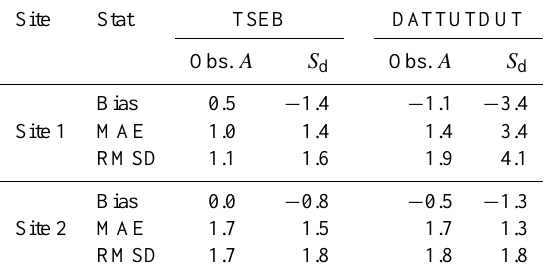
Table 4. Difference statistics for daytime ET (MJm − 2 day − 1 ) ex- trapolated from instantaneous estimates using observed available energy A (obs. A ) from flux towers versus using incoming solar radiation measurements ( S d